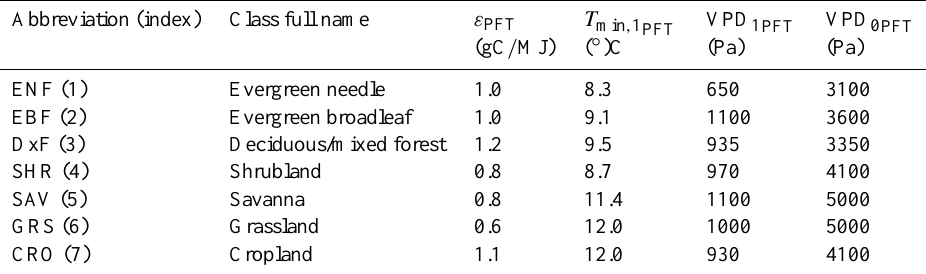
Table 2. Descriptive abbreviations used for PFTs and the values of PFT-dependent parameters of the photosynthesis model. ε max : maximum light use efficiency per PFT, T min , 1PFT : the daily minimum temperature at which ε = 0 . 0 (at any VPD), VPD 1PFT : the daylight average vapor pressure deficit at which ε = 0 . 0 (at any T min ), VPD 0PFT : the daylight average vapor pressure deficit at which ε = ε max (for optimal T min ). The values of the parameters are modified from the Biome Properties Look-Up Table (BPLUT) for MOD17 (Heinsch et al.,